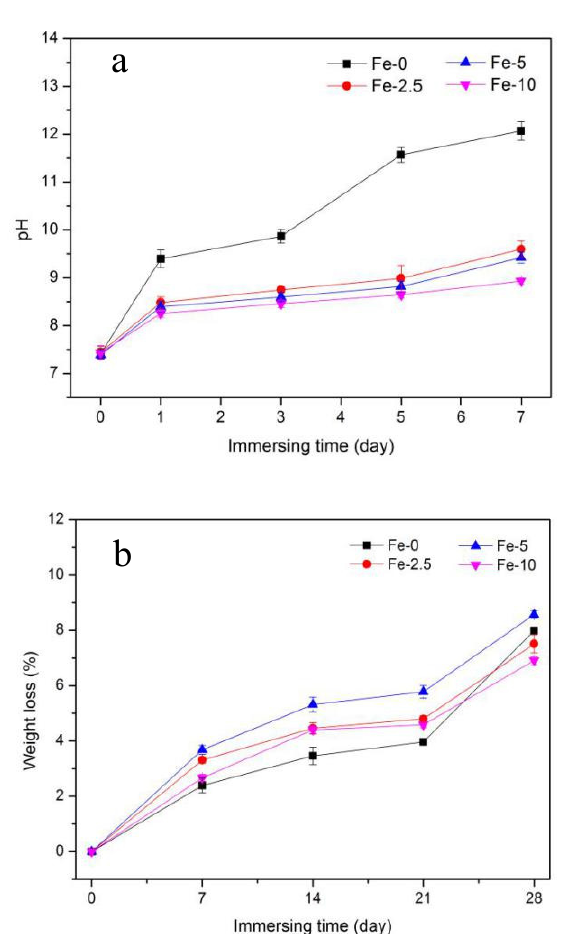
Figure 3. pH value ( a ); and weight loss ( b ) of Fe-0, Fe-2.5, Fe-5 and Fe-10 bone cement samples after immersing in SBF solution.